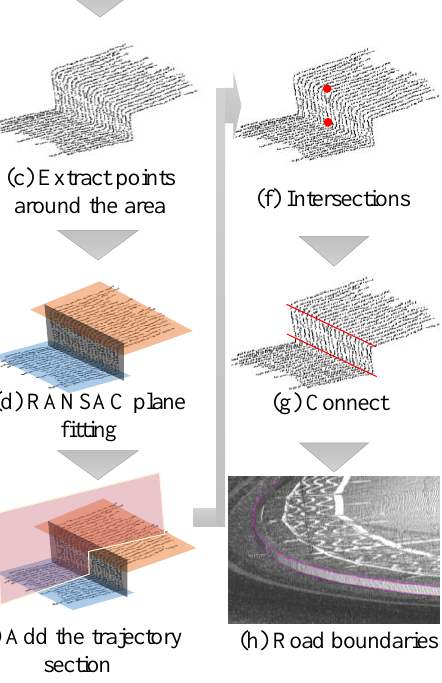
Figure 4. Drawing procedure of road